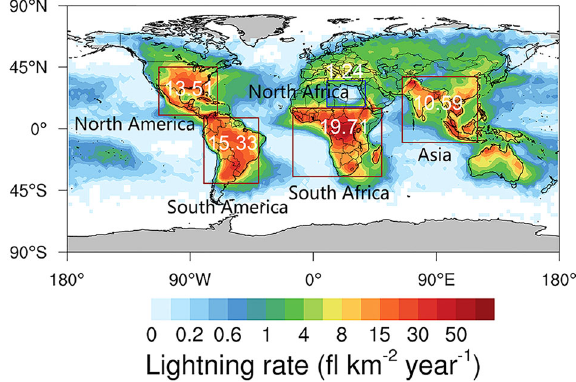
Fig. 1 Spatial distribution of annual averaged lightning fl ash rate. Lightning fl ash rate is derived from LIS/OTD datasets from July 1995 to January 2014. The four continental regions (North America, Asia, South America, and South Africa) with the highest lightning frequency in the world are marked with red rectangles. The region with a weak lightning fl ash rate (North Africa) is marked with a blue rectangle. The white values (unit: fl km − 2 year − 1 ) indicate the average lightning density in each continental